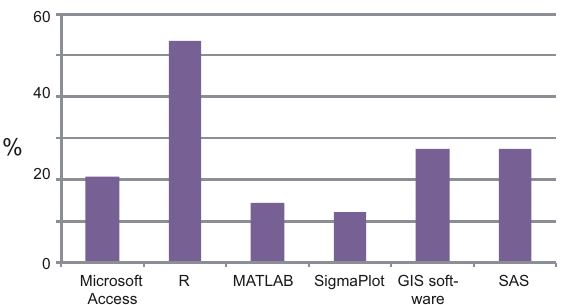
Figure 6. Percent of researchers surveyed that reported using a given program alongside Excel. n =